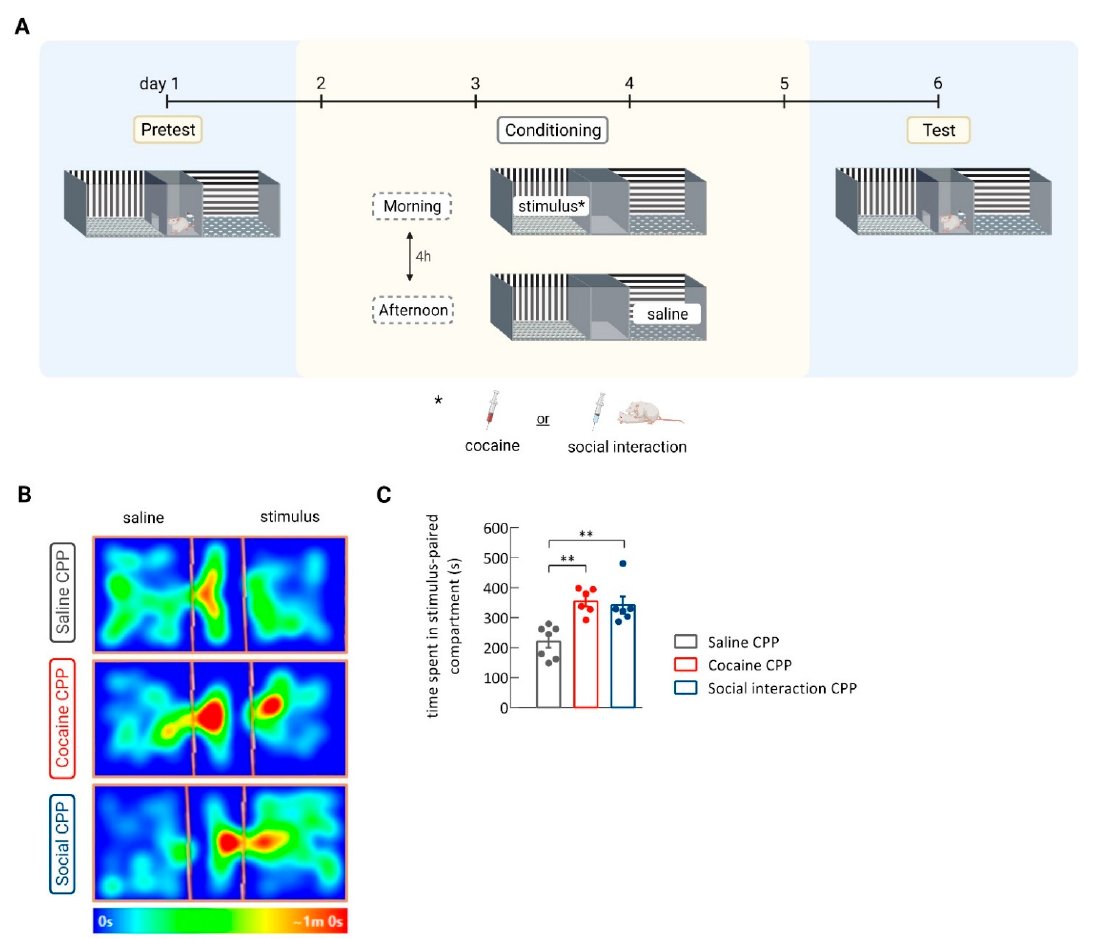
Figure 1. Conditioned place preference to cocaine or social interaction. ( A ) Timeline. ( B ) Representative heatmaps of the time spent in each compartment during the CPP test of rats receiving saline injections in both compartments of the CPP (saline CPP), and rats conditioned to cocaine (cocaine CPP) or social interaction (social CPP). ( C ) Time rats spent in the saline-, cocaine- and social interaction-associated compartments during the CPP test. ** p < 0.01, one-way ANOVA followed by Newman–Keuls multiple comparisons test; n = 6–7. Results are presented as mean ± SEM.